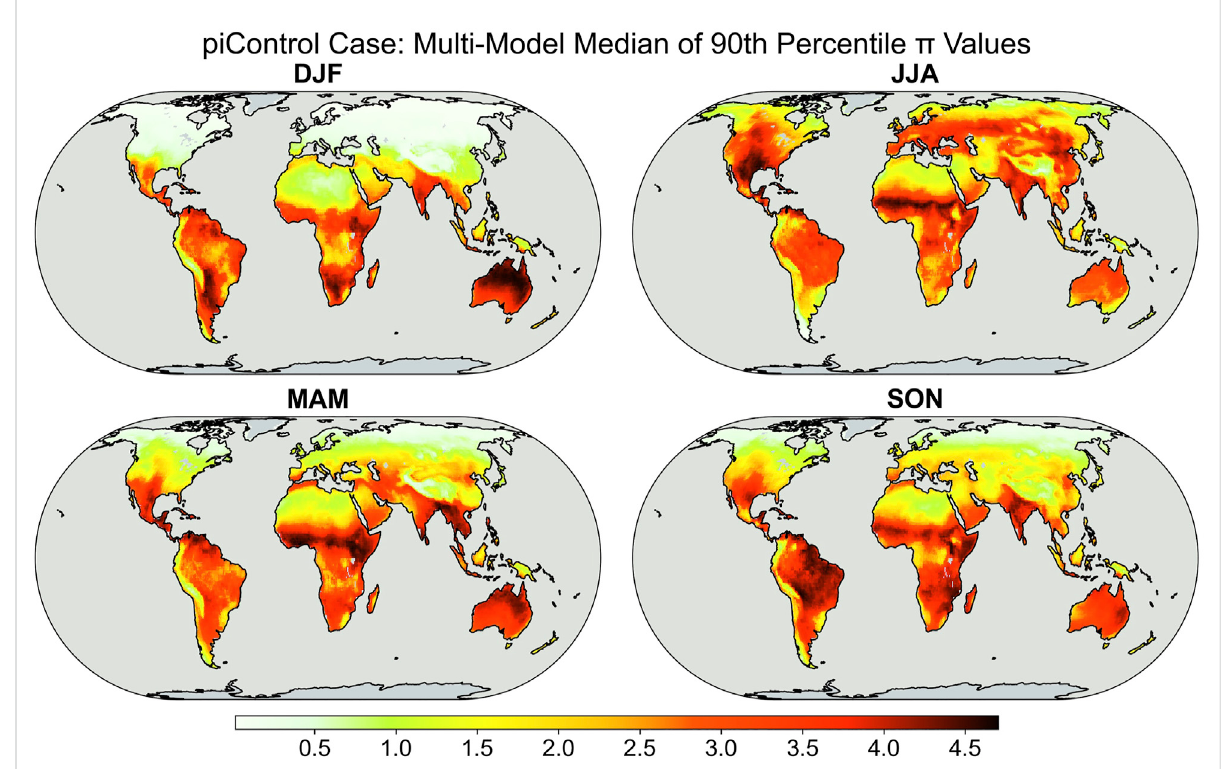
FIGURE 5 Multimodelmedianofthe90thpercentilevaluesofmonthlyscalesoilmoisture – temperaturecoupling( π ;dimensionless)foreachseasonfrom preindustrial control (piControl) simulations. Values are calculated over ice-free land areas only.